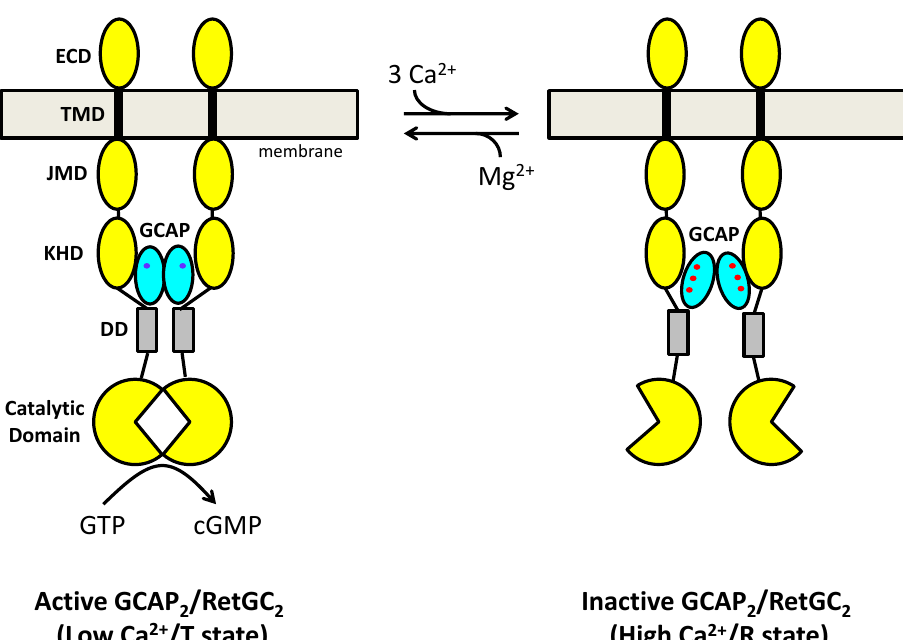
Figure 4. Allosteric regulation of a GCAP 2 /RetGC 2 complex. Cyclase activity (synthesis of cGMP) is modulated by a Ca 2+ -dependent change in the quaternary structure of the GCAP 2 /RetGC 2 complex. The Ca 2+ -free/Mg 2+ -bound GCAP1 dimer (cyan ovals with bound Mg 2+ in blue) binds to the RetGC dimer (yellow) and activates cyclase activity (left panel). The Ca 2+ - bound GCAP1 dimer (cyan ovals with three bound Ca 2+ in red) binds to the RetGC dimer (yellow) and inactivates cyclase activity (right panel). Thus, the binding of 3 Ca 2+ to the GCAPs promotes the T → R transition (turns off cyclase activity), whereas the dissociation of Ca 2+ and binding of Mg 2+ promotes the R → T transition (turns on cyclase activity). Each RetGC dimer subunit is composed of an extracellular domain (ECD), transmembrane domain (TMD in black), juxtamembrane domain (JMD), kinase homology domain (KHD), dimerization domain (DD, gray), and catalytic cyclase domain (notched circles).